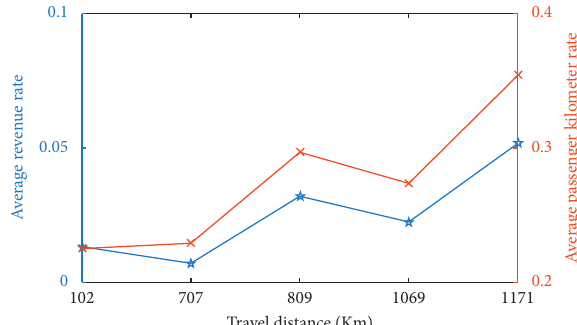
Figure 11: The rate of average revenue and passenger kilometer to travel distance.